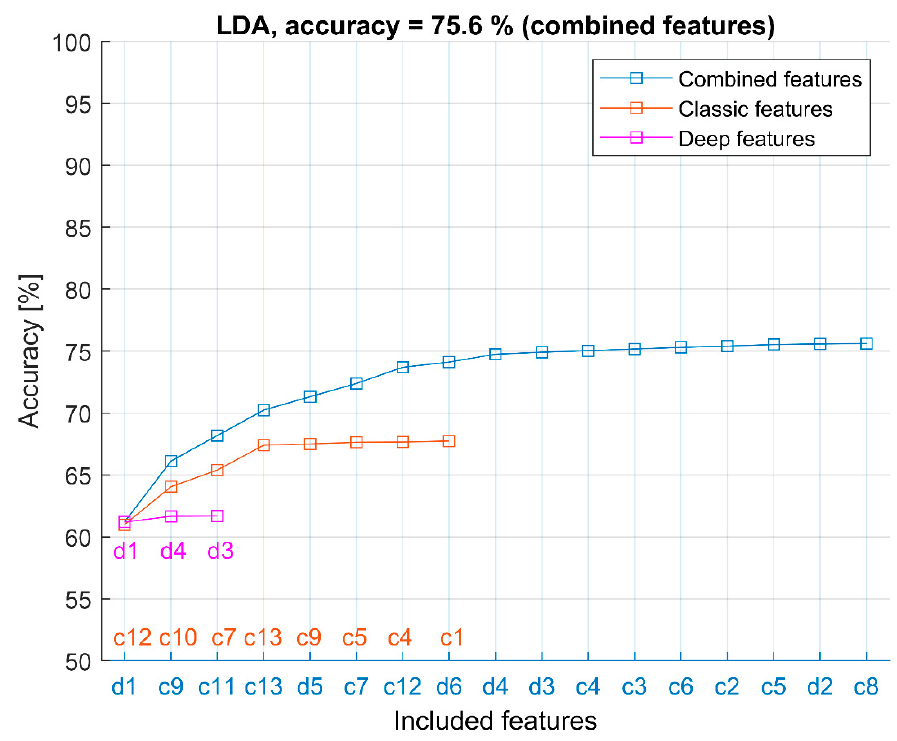
Figure 4. LDA classifier and selected combined features (d1, c9, c11, c13, d5, . . . ) in CAE-1 configuration “16-32-14-256-6-100-128”.